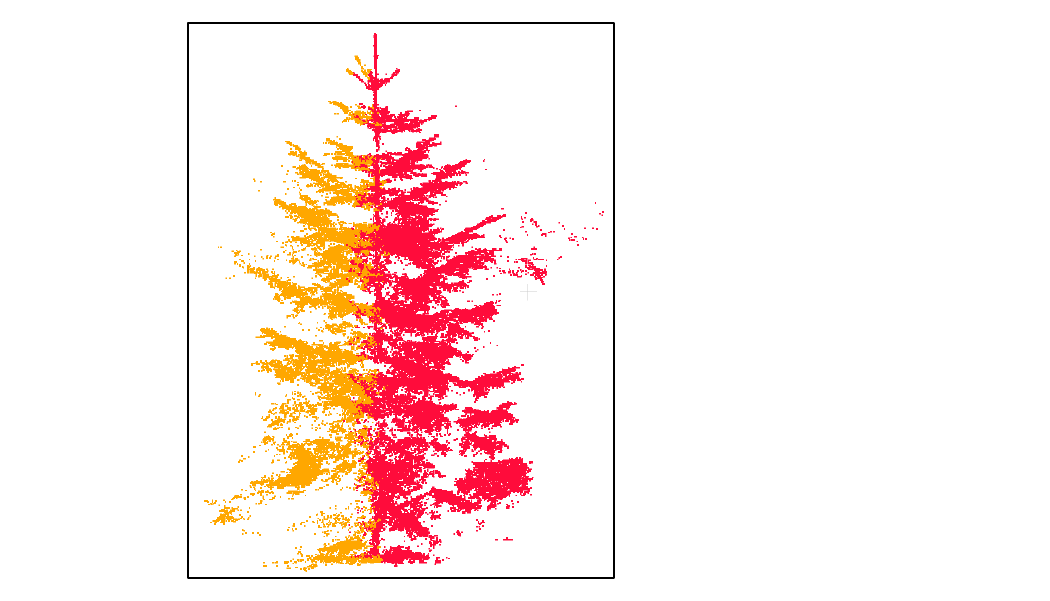
Figure 6. The ‘split tree’ error occurs when segmentation results split one tree into two because branches provide paths to the ground which do not route through the trunk.